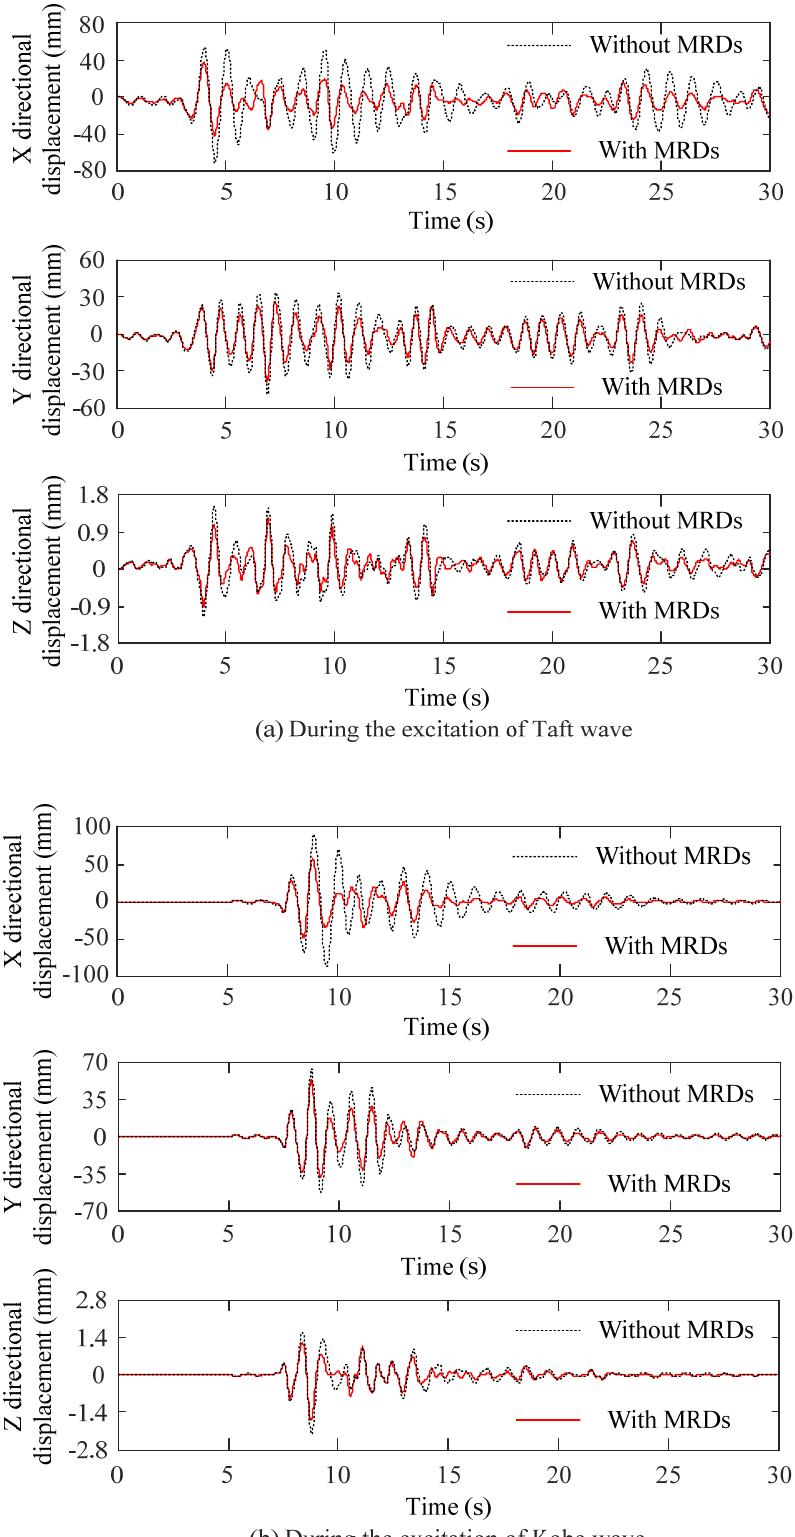
Figure 9. Contrasts of displacement response of Node 154 of the structure with and without MRDs.